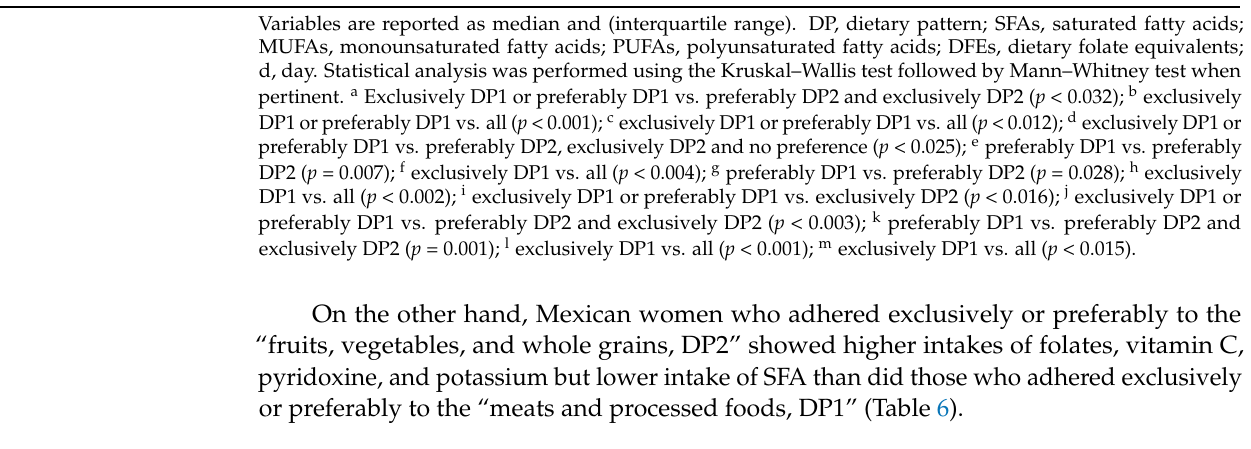
Table 6. Macro- and micronutrient intake of 215 Mexican women by adherence to dietary